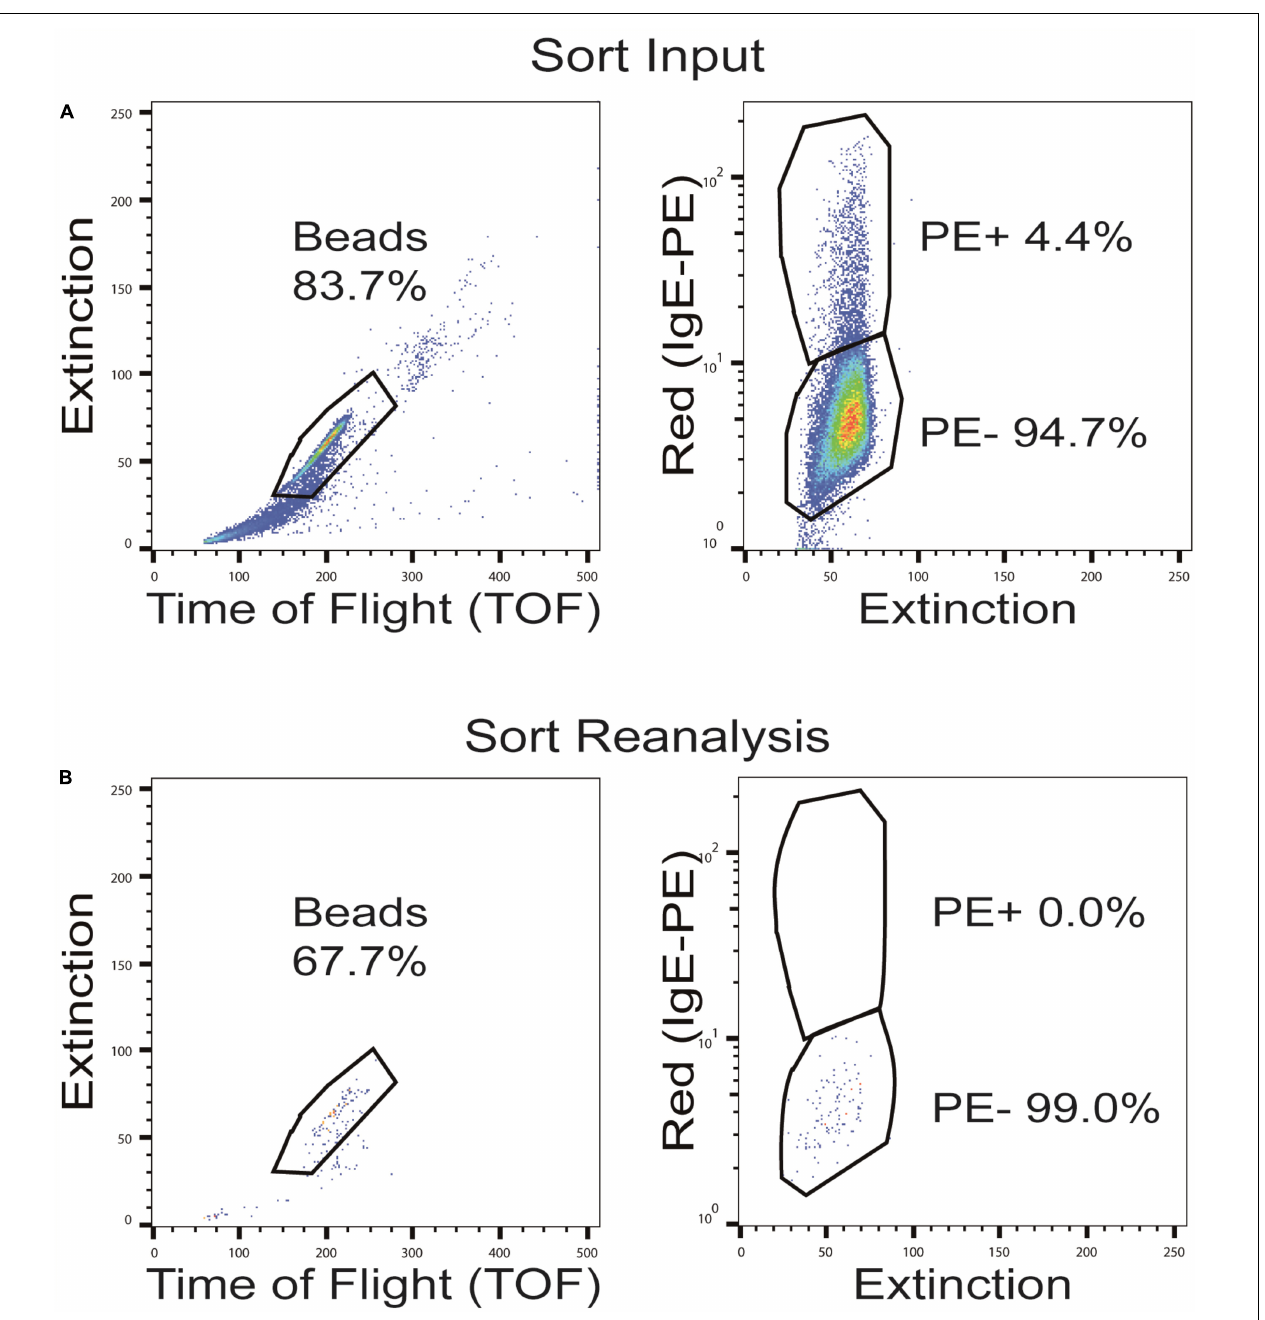
FIGURE 6 | Sorting of OBOC beads after pre-adsorption with the phycoerythrin (PE)-labeled anti-IgE antibody. Representative dot plots with full gating of (A) the total pre-adsorbed OBOC library showing the anti-IgE cross-reactive beads in the upper PE+ gate and the non-cross-reactive beads in the lower PE- gate, and (B) re-analysis of the pre-cleaned non-cross-reactive bead fraction (PE-) after